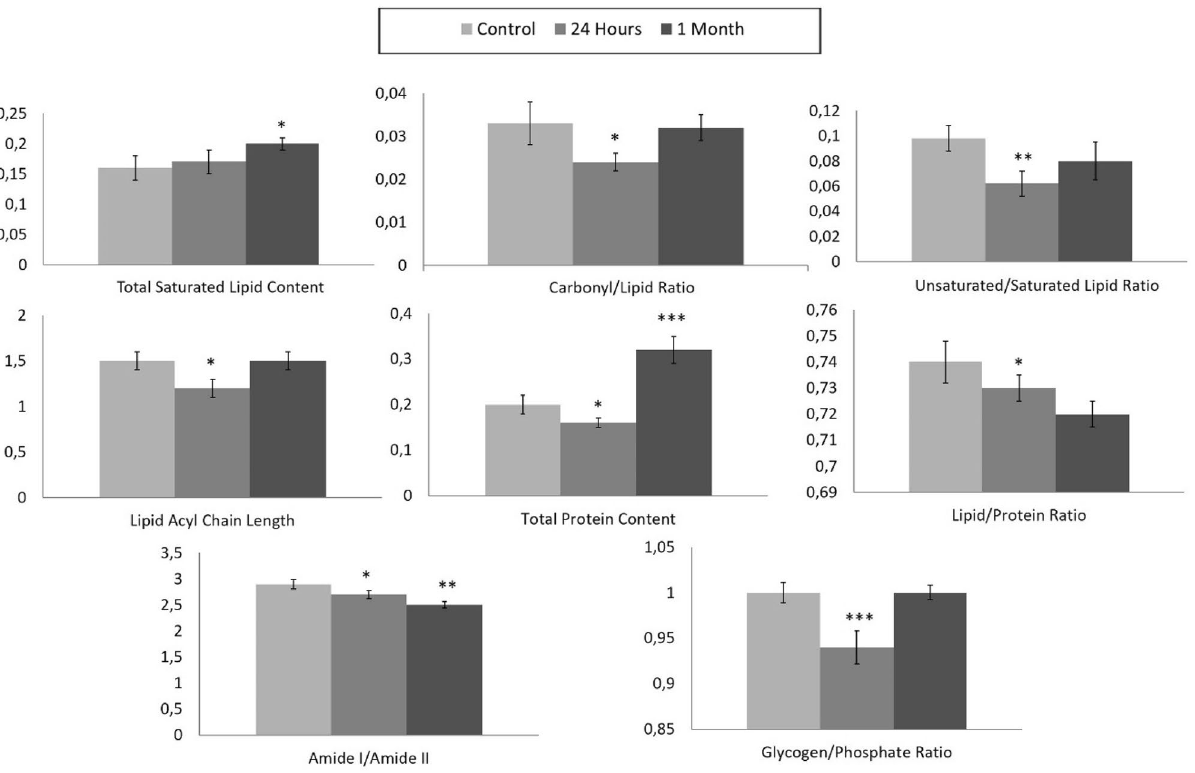
Figure 4. Histograms of the calculated parameter values (total saturated lipid content, carbonyl/lipid, unsaturated/saturated lipid, lipid acyl chain length, total protein content, lipid/protein, amide I/amide II and glycogen/phosphate band area ratios) for 24 h and 1-month TBI groups. Statistical significance was determined by one-way ANOVA with Tukey’s post hoc test and the 95% confidence interval. Bars represent mean ±